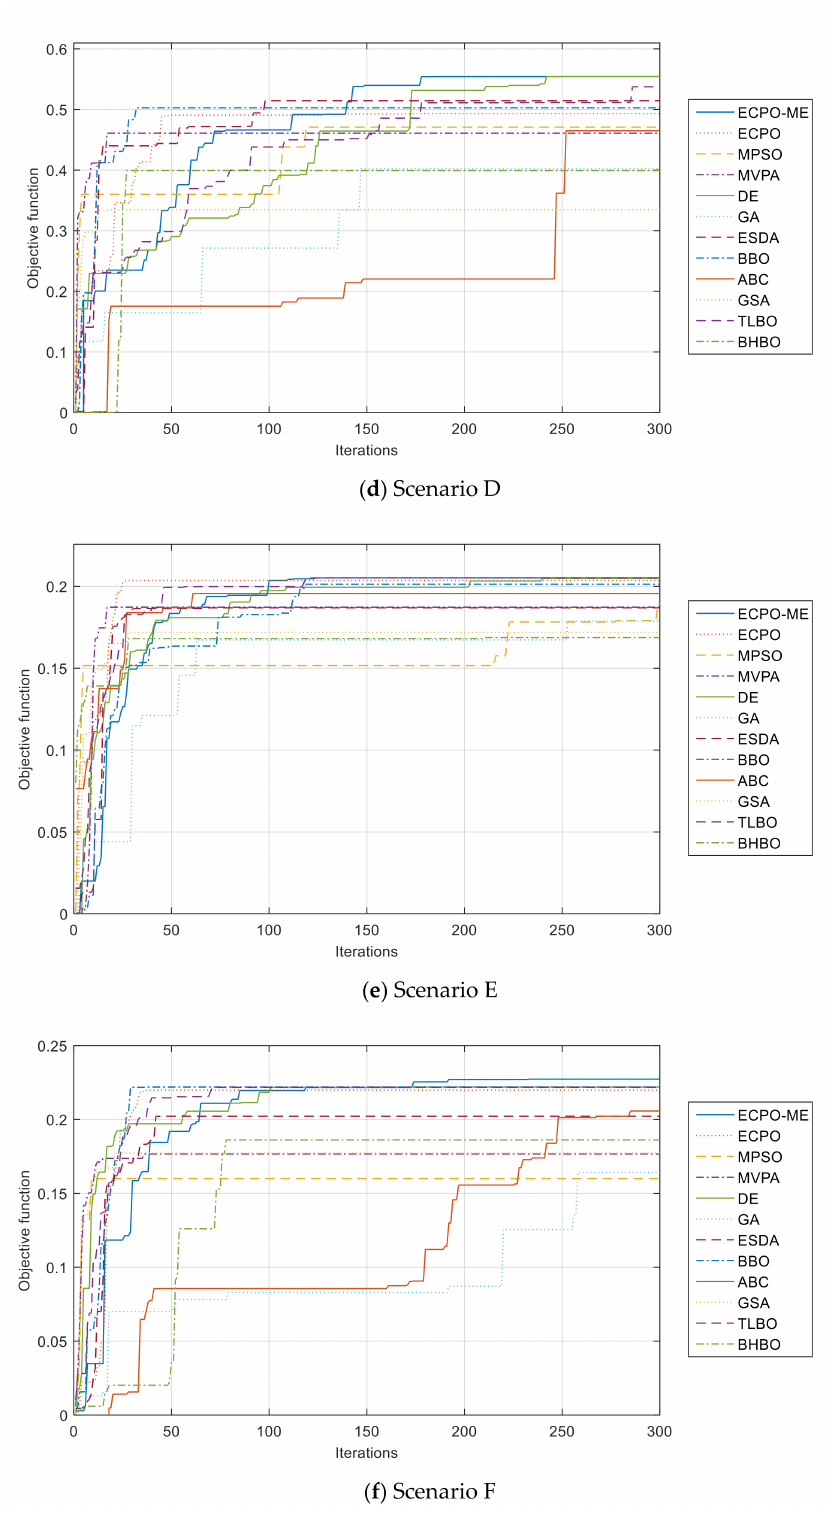
Figure 10. Convergence curves of the ECPO-ME for all